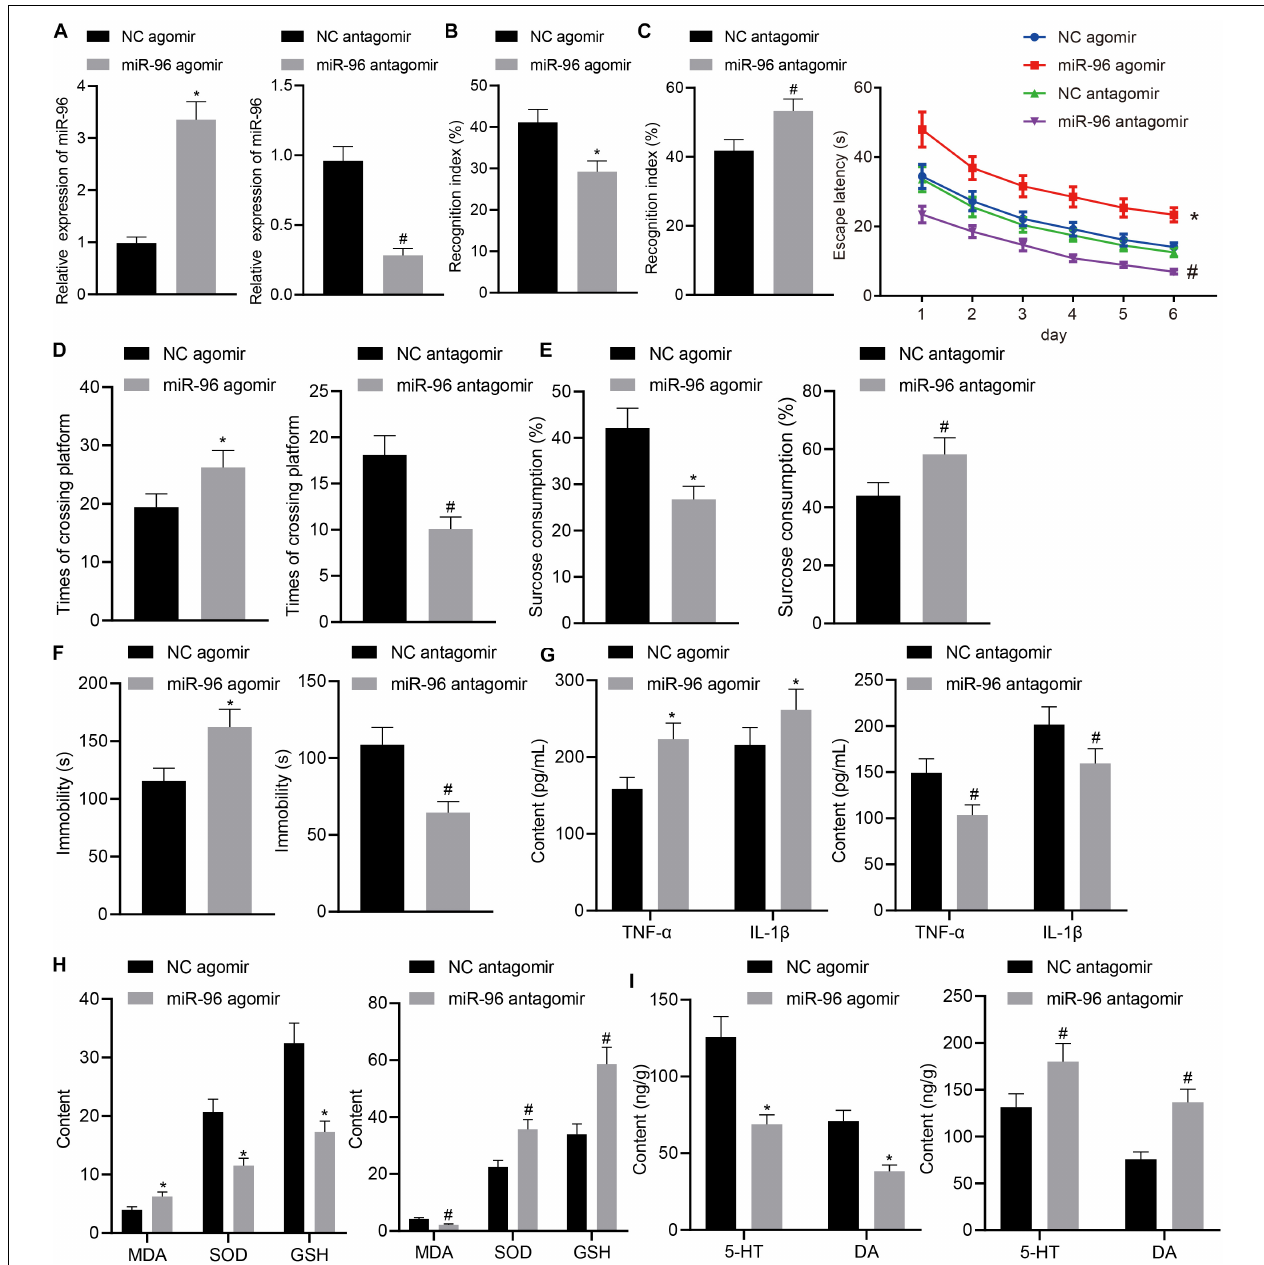
FIGURE 2 | Downregulation of miR-96 relieved depression-like behavior and memory impairment in LPS-treated mice. LPS-treated mice were injected with NC agomir, miR-96 agomir, NC antagomir, or miR-96 antagomir. (A) RT-qPCR detection of miR-96 expression in mouse CA1 region [ N = 10, t agomir (10.89) = 20.41, t antagomir (12.84) = 18.69]. (B) NORT index of mice [ N = 10, t agomir (18) = 9.352, t antagomir (18) = 7.684]. (C) Escape latency time of mice in Morris water maze experiment [ N = 10, F (15,216) = 2.715]. (D) Frequency of crossing platform by Morris water maze experiment [ N = 10, t agomir (18) = 5.747, t antagomir (18) = 10.35]. (E) Sucrose preference index of mice [ N = 10, t agomir (18) = 9.588, t antagomir (18) = 6.163]. (F) Swimming immobility time of mice in forced swimming experiment [ N = 10, t agomir (18) = 7.893, t antagomir (18) = 10.47]. (G) Levels of inflammatory factors TNF- α and IL-1 β in CA1 region of brain in mice detected by ELISA [ N = 10, t agomir , TNF − α (18) = 7.996, t agomir , IL − 1 β (18) = 4.068, t antagomir , TNF − α (18) = 7.685, t antagomir , IL − 1 β (18) = 5.275]. (H) Levels of MDA, SOD, and GSH in CA1 region of brain in mice [ N = 10, t agomir , MDA (18) = 7.679, t agomir , SOD (18) = 11.54, t agomir , GSH (18) = 12.40, t antagomir , MDA (18) = 10.83, t antagomir , SOD (18) = 10.07, t antagomir , GSH (18) = 11.21]. (I) Levels of 5-HT and DA in hippocampal CA1 region of mice [ N = 10, t agomir , 5 − HY (18) = 12.21, t agomir , DA (18) = 12.82, t antagomir , 5 − HY (18) = 6.327, t antagomir , DA (18) = 11.87]. * p < 0.05 vs. LPS-treated mice injected with NC agomir, # p < 0.05 vs. LPS-treated mice injected with NC antagomir. Measurement data were expressed as mean ± standard deviation. When data were in compliance with normal distribution and homogeneity of variance, unmatched data between two groups were compared using unpaired t -test. Statistical analysis in relation to time-based measurements within each group was realized using repeated-measures ANOVA, followed by Bonferroni’s post hoc test. Cell experiment was independently repeated three times.